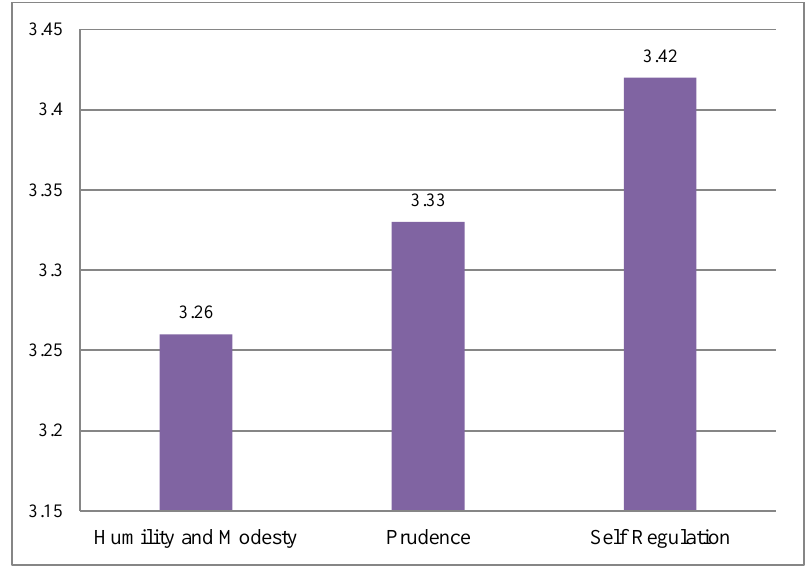
Fig. 6. 5th virtue: Temperance (means, rated on a 5-point scale,